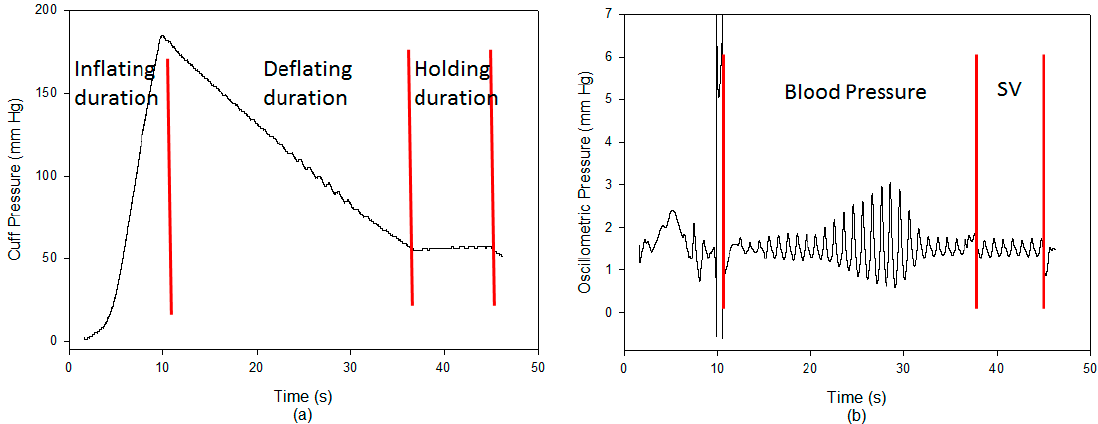
Figure 1. ( a ) The cuff pressure has three phases, inflating duration, deflating duration, and holding duration. ( b ) The oscillometric signal was used to measure the blood pressure, the pulse signal was used to measure the stroke volume during the holding duration.